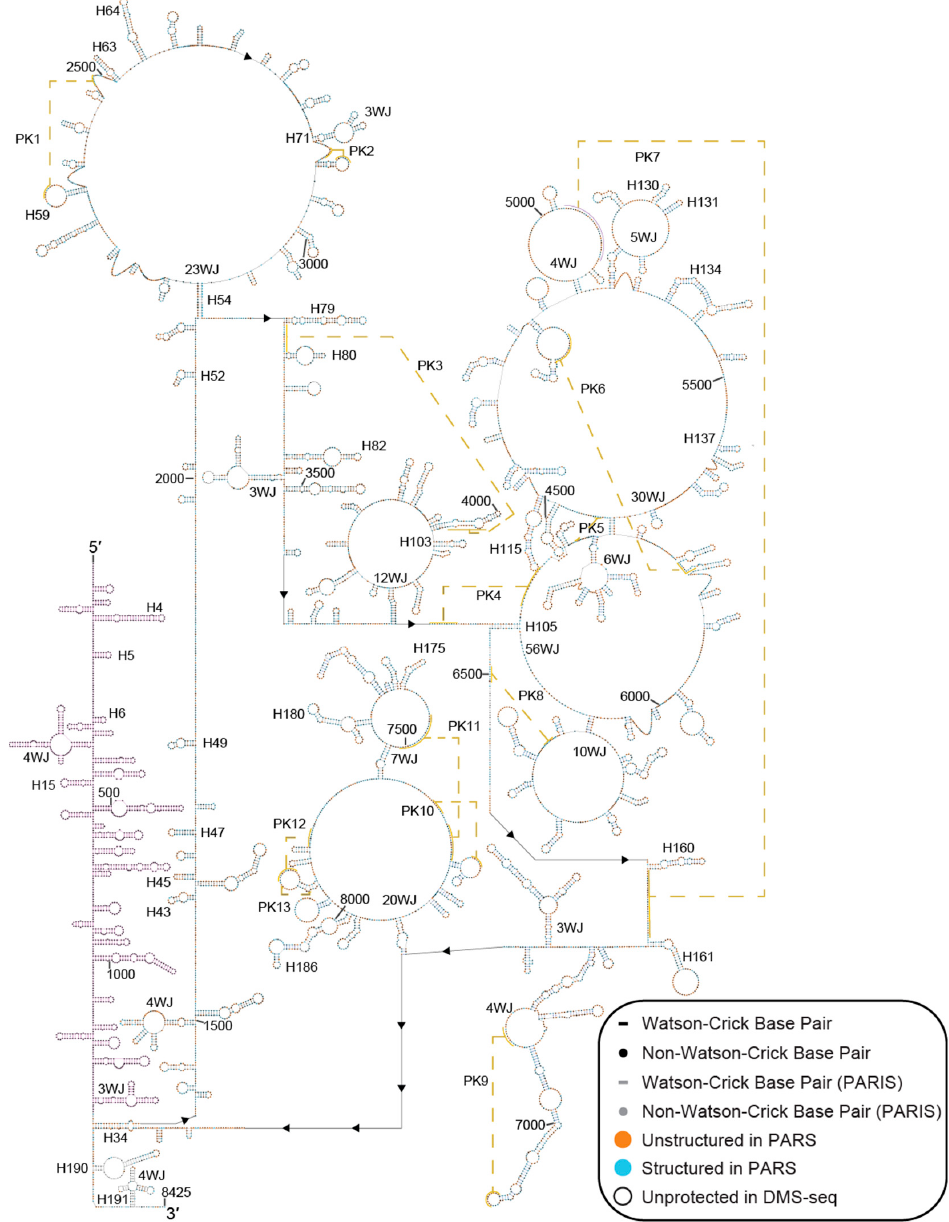
Figure 2. The secondary structural model of human MALAT1. The secondary structures for the composite model are shown with PARS, DMS-seq, and PARIS data annotated as follows: Watson–Crick base pairing (line) and non-Watson–Crick base pairing (dots) are black unless detected by PARIS (gray lines and dots); nucleotide positions with orange and blue circles represent nucleotides that were unstructured and structured, respectively, in PARS and the black outline denotes adenosine and cytidine residues considered unprotected in DMS-seq. The structure of nts 1–1280 (purple) was determined only using MFE calculations from RNAfold [32]. Secondary structures are labeled as follows: H for helix, PK for pseudoknot, and multiway junction as WJ, which is preceded by the number of junctions (e.g., 3WJ for a three-way junction). Each secondary structure is numbered in order of appearance from 5 ′ to 3 ′ . For clarity, only helices specifically mentioned in the text are labeled; see Table S1 for a complete list of named structures. The solid lines with an arrowhead in the middle of the line denote 0 nt distance. The yellow dashed lines indicate RNA–RNA interactions in helices or pseudoknots. SAVoR and VARNA were used to visualize the model [33,34].